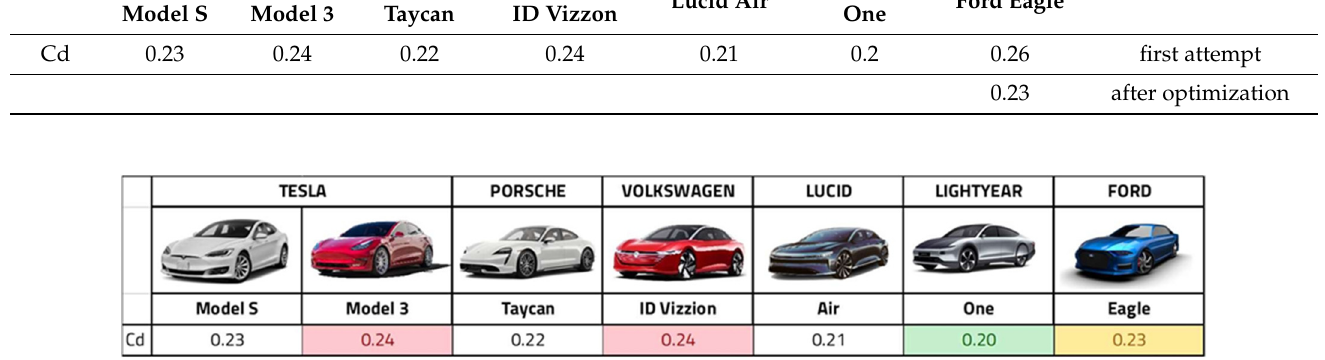
Table 5. Comparison of Cd values after optimization phase.